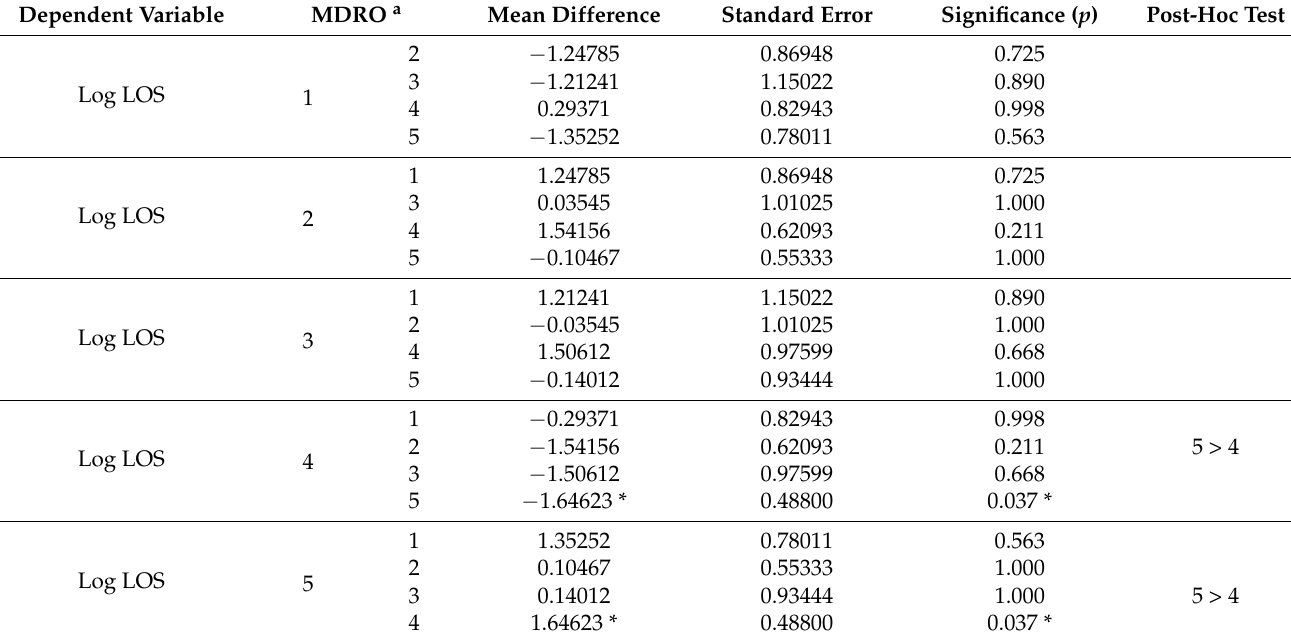
Table 4. Table of post hoc tests of log LOS of different anti-drug